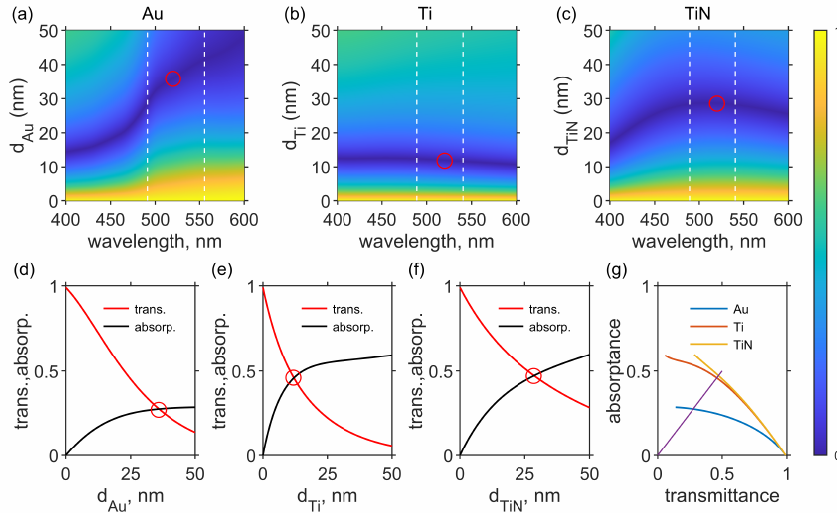
Figure 3. ( a – c ) | T m − A m | of the different metal film calculated by Equation (3) in range from 400 to 600 nm. The white lines shows the edges of the photonic crystal band gap. ( d – f ) Dependence of the transmittance and absorptance of the metal film on its thickness. ( g ) Dependence of absorptance of the metallic film on its transmittance for different film materials. The A m ( T m ) curves cross the critical coupling condition curve (purple line). The cross points represent the critical coupling conditions for TPP resonance for different materials of the metal layer. The wavelength is λ = 515 nm.